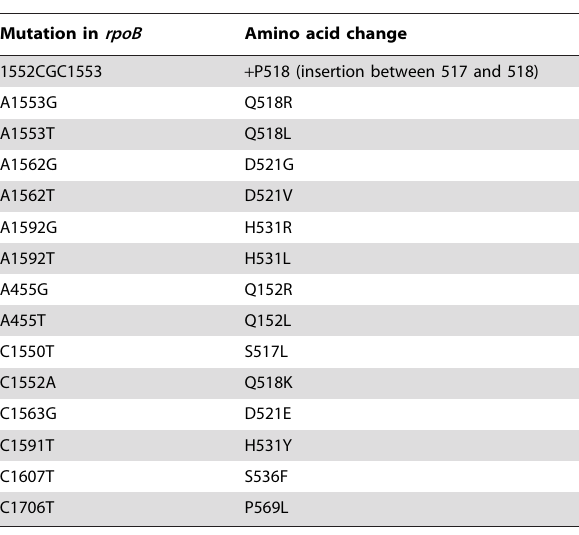
Table 1. Beneficial